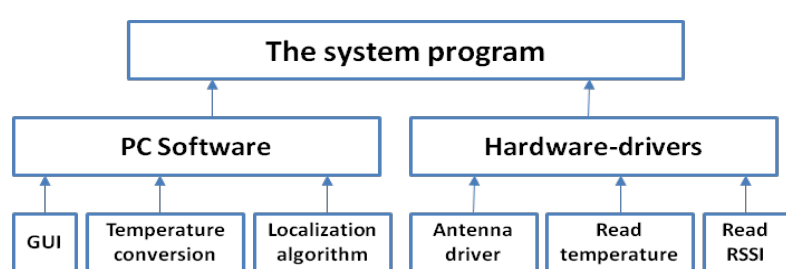
Figure 2. The system program